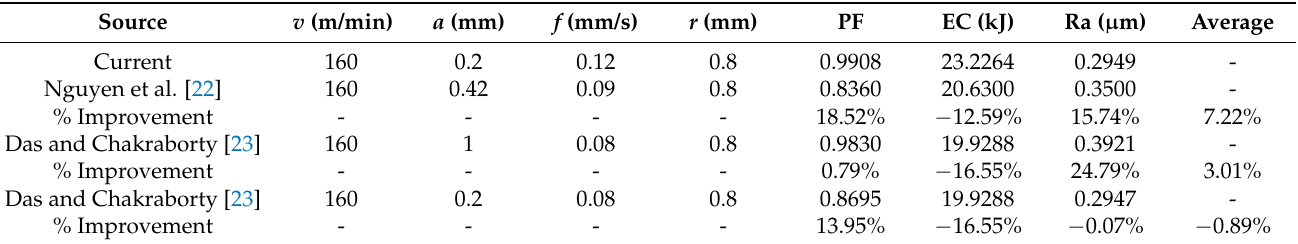
Table 7. Comparison with results from literature.